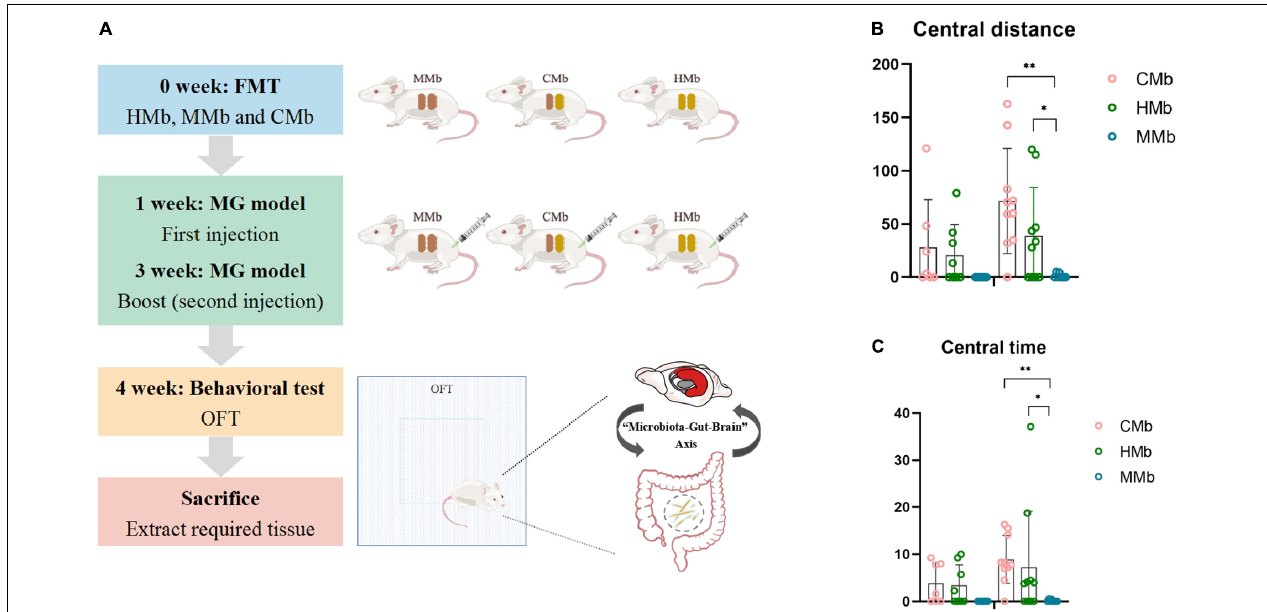
FIGURE 1 | Flow chart and behavioral performance of the experiment. (A) Flow chart of the experiment. (B,C) Central motion distance and central activity time in both genders among CMb, HMb, and MMb. Notably, compared with female mice in the HMb group, central motion distance ( p = 0.035) and central activity time ( p = 0.022) in female MMb was lower, and this difference could be reversed by co-colonization (central motion distance, p = 0.000; central activity time, p = 0.005). ∗ p < 0.05, ∗∗ p < 0.01. FMT, fecal microbiota transplantation; MG, myasthenia gravis. MMb, GF mice ( n = 15) were initially colonized with gut microbiota from MG patients (male/female = 7/8); HMb, GF mice ( n = 18) were colonized with gut microbiota from healthy individuals (male/female = 8/10); CMb, GF mice ( n = 17) were simultaneously colonized with gut microbiota from both MG patients and healthy individuals (male/female = 7/10). M, male; F,